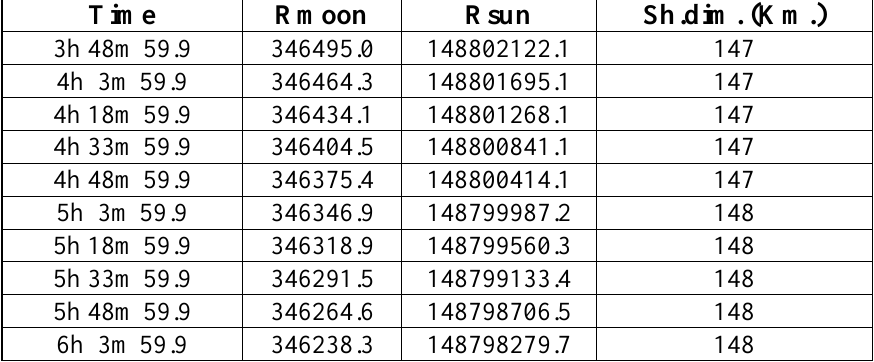
Table 1: YY = .3710349801